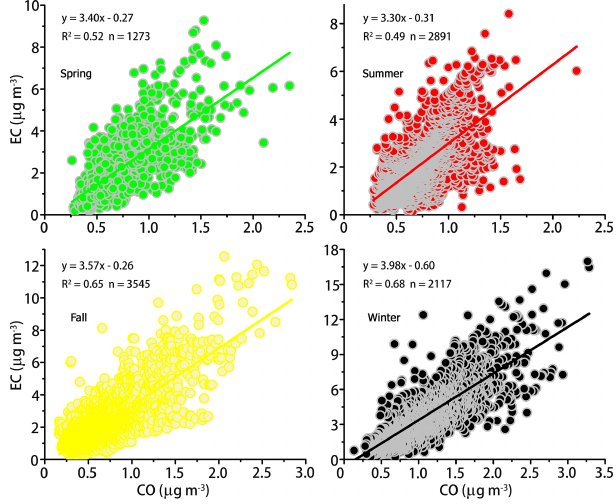
Figure 9. Correlation analysis of the mass concentrations of CO and EC during four seasons in Shanghai.